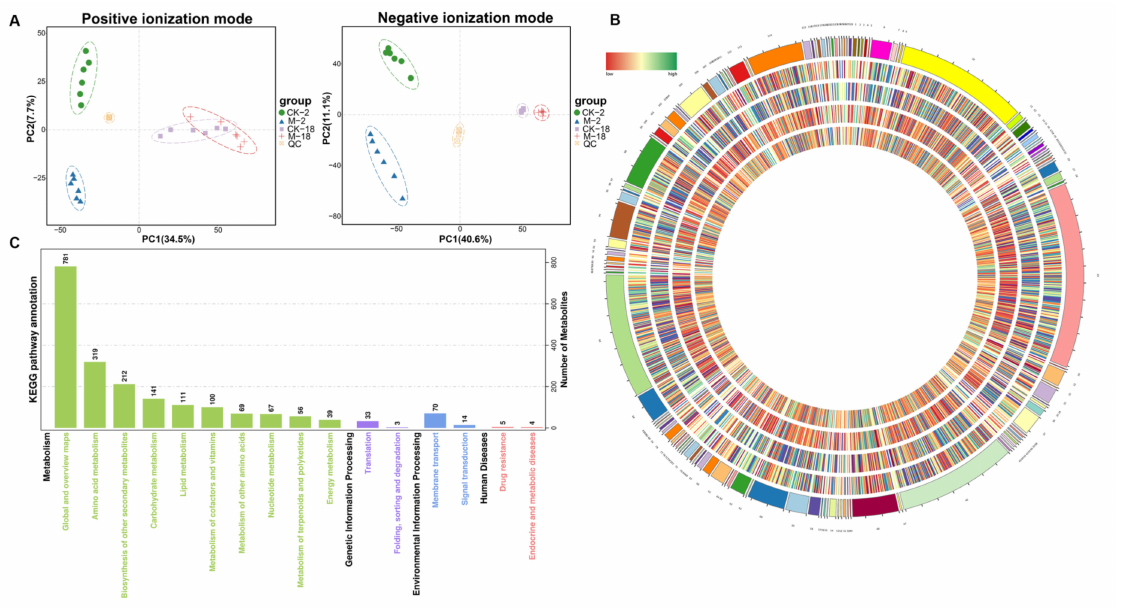
Figure 4. Metabolite profiles identified in GN2 (salt-tolerant) and GN18 (salt-sensitive) seeds with 24 h treatments involving water (CK) and 200 mM salt solution (salt treatment, M). ( A ) PCA of metabolomic profiles with quality control in positive and negative ionization modes. Overall score plot of seed samples collected at GN2 (CK-2 vs. M-2) and GN18 (CK-18 vs. M-18). ( B ) Circular diagram of all metabolites in the different groups, showing, from the outer circle to the inner circle, the metabolites of GN2 and GN18, respectively. ( C ) KEGG pathway enrichment analysis was performed for all identified